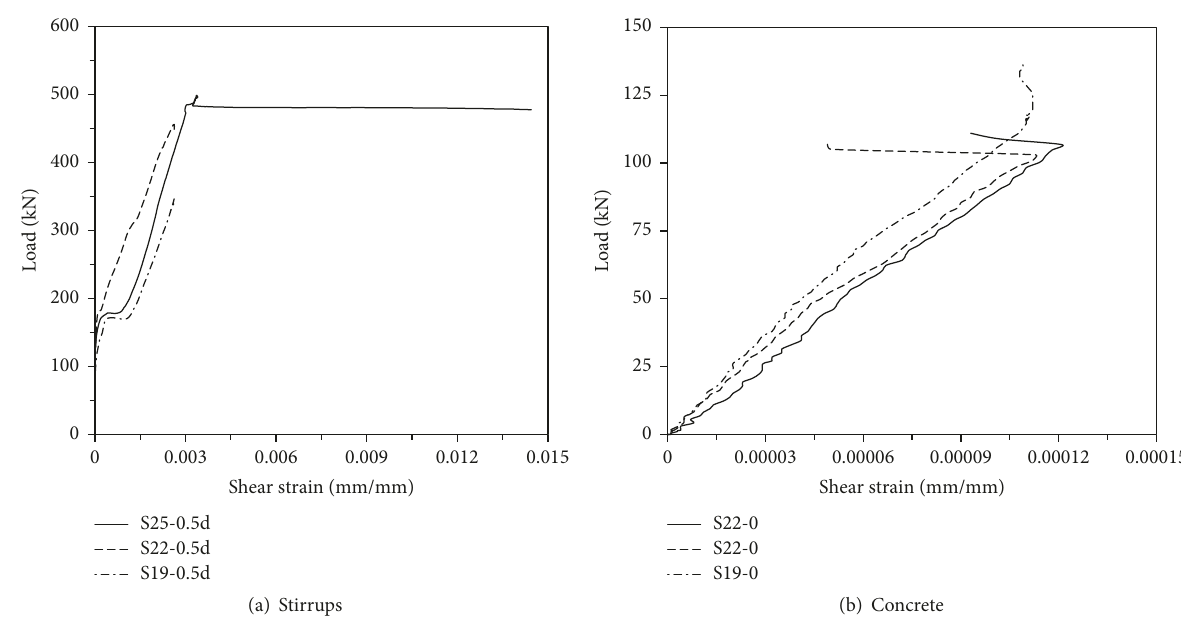
Figure 11: Load versus shear strain in shear test